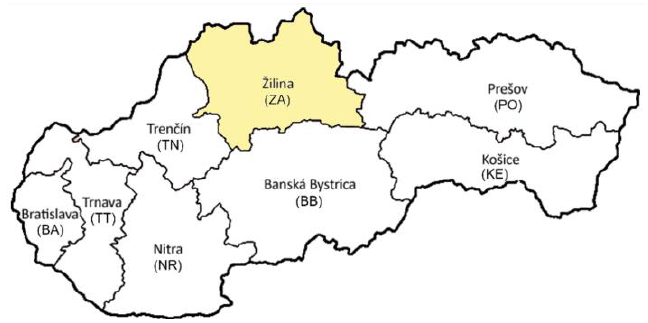
Figure 3. Self-governing regions of Slovakia.